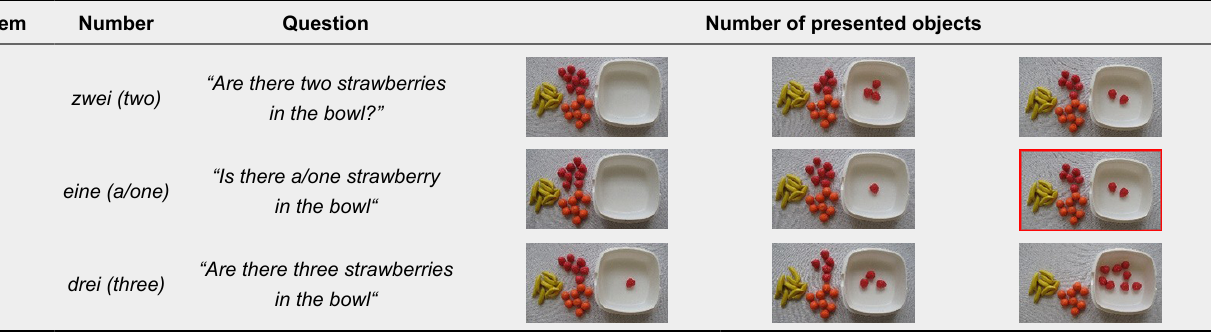
Different Conditions for the Number-Biasing